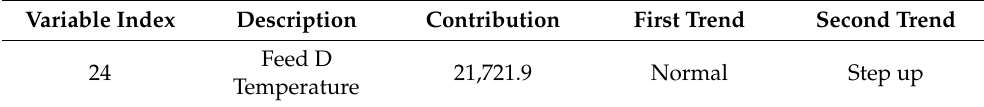
Table 5. The contributions of abnormal variables in 10 min for Mode 2 fault 3.